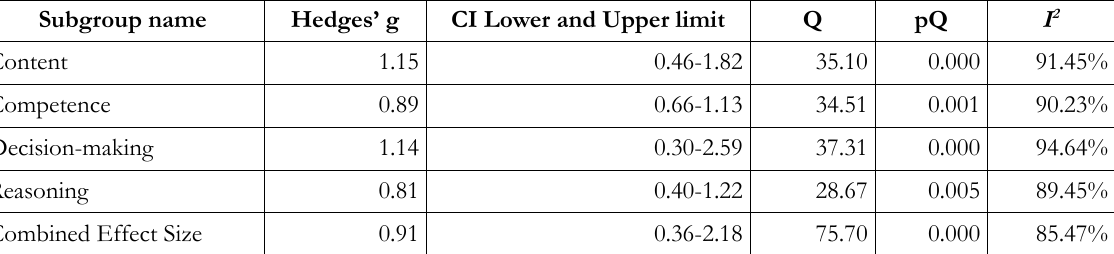
Table 8. Effect Size by Dependent Variables